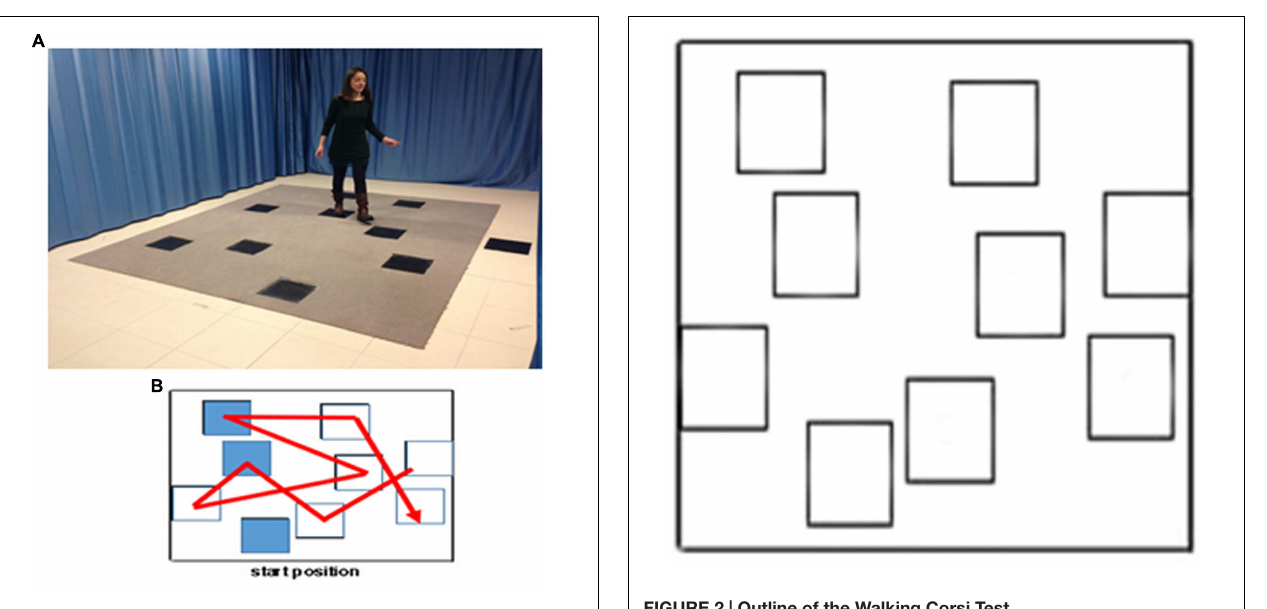
FIGURE 1 | The landmark-based navigational memory task. The eight-square path was designed in order to let participants move through the squares, as showed by the red line. (A) Experimental set-up. Written informed consent was obtained from the subject represented in the figure for publication of this experiment. A copy of the written consent is available for review by the Editor-in-Chief of this journal. (B) Disposition of the positive, negative and neutral landmarks through the path.